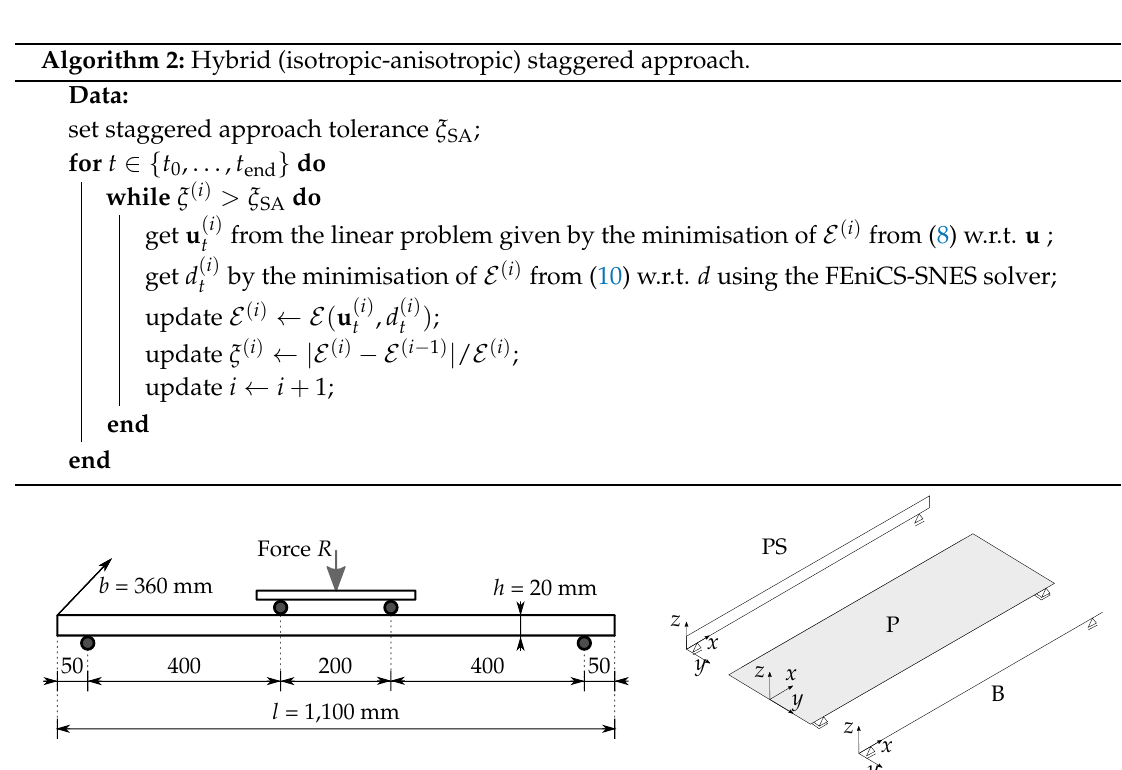
Figure 3. Four-point bending loading scheme and geometry of a glass sample and three different spatially reduced models, i.e., 2D plane-stress (PS) longitudinal cross-section, Reissner–Mindlin plate (P), and Timoshenko beam